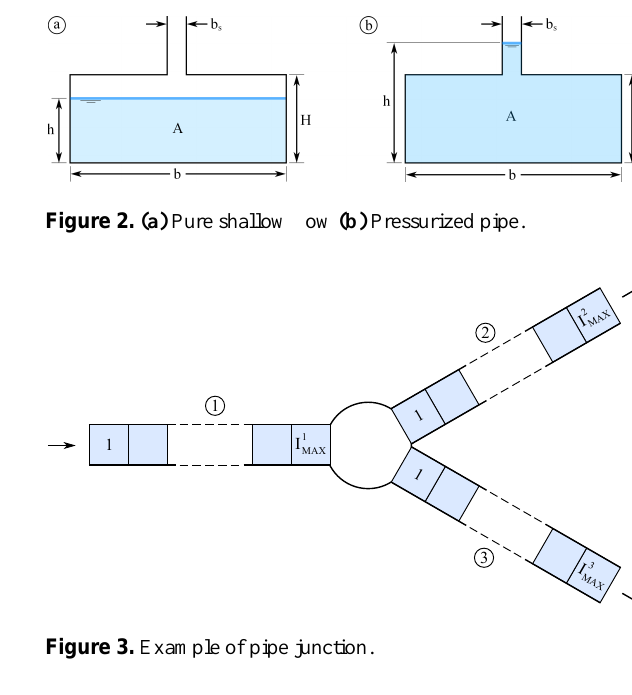
Table 2. Boundary conditions.